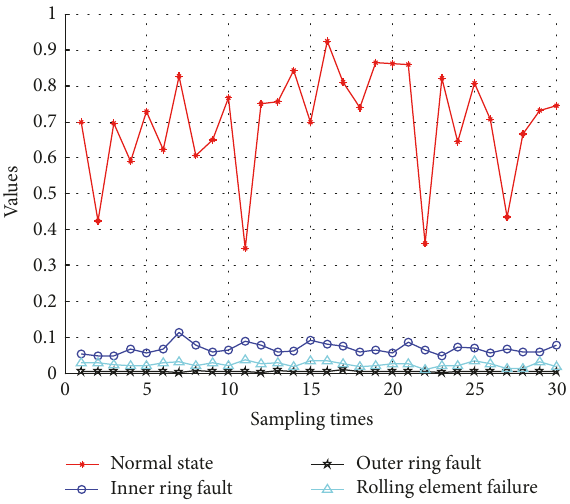
Figure 11: Time domain index (energy) for four cases.